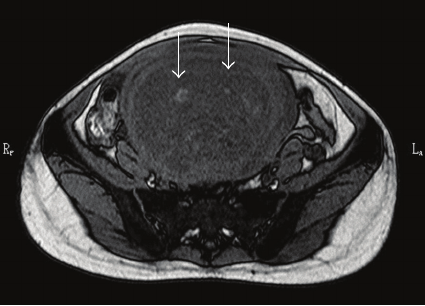
Figure1:Magneticresonanceimagingoftheuterinetumorshowing a small area of high-signal intensity (arrows) on a T1-weighted image.